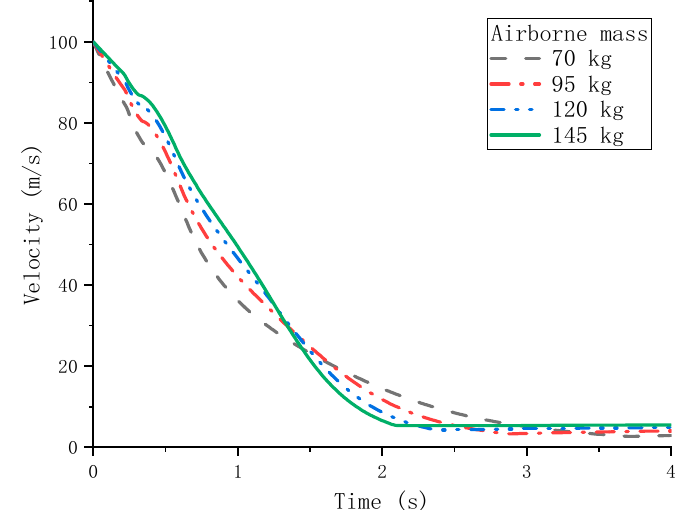
Figure 9. Velocity changes of parachute systems with different